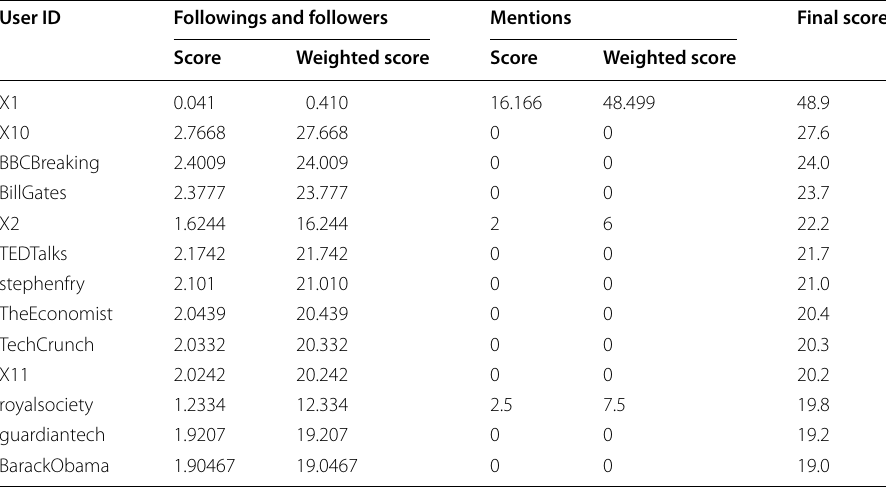
Table 5 Interaction based configuration results break-down of